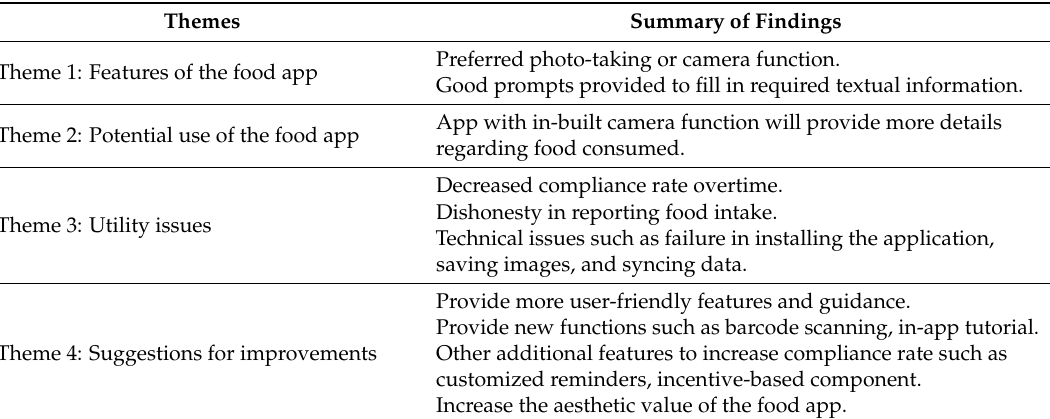
Table 3. Summary of findings from the focus group discussions. Themes Summary of